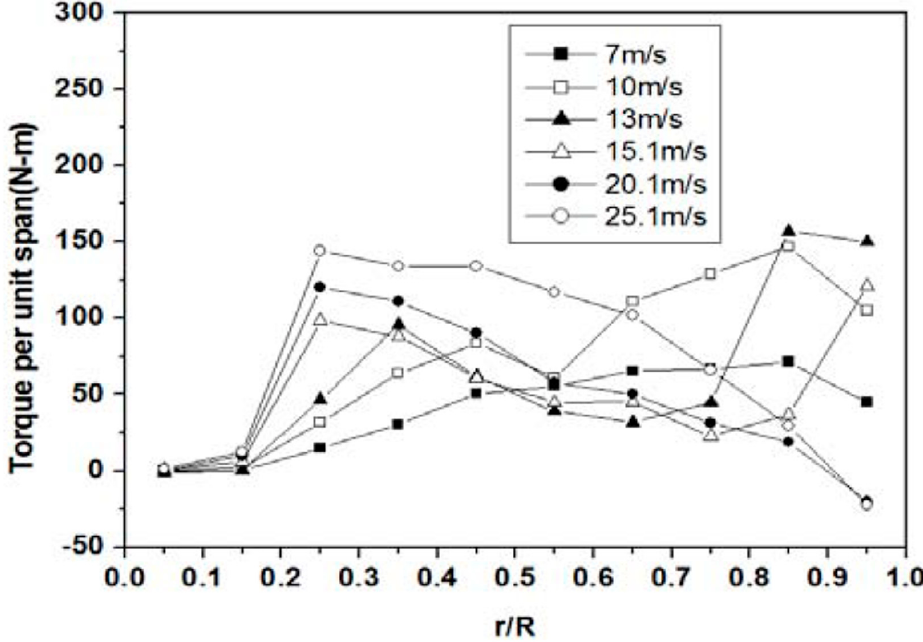
Figure 22. Torque generated at different radial locations. [Young-Ho LEE], [Journal of Mechanical Science and Technology 26 (1)]; published by [Springer], [2012],. [27].